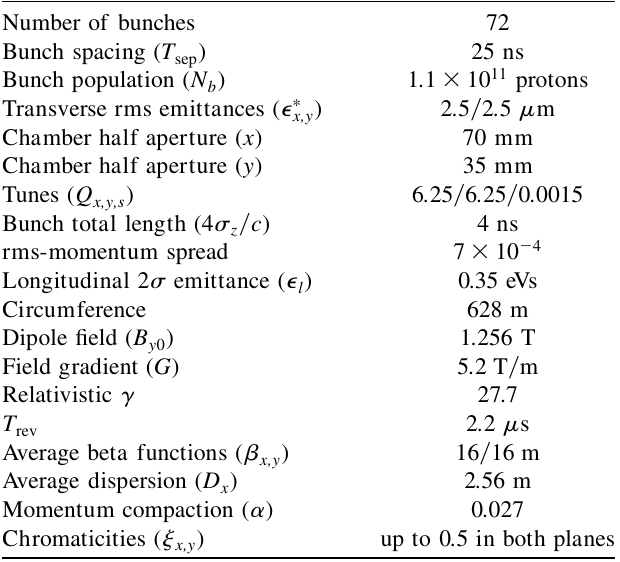
TABLE I. Main parameters of the LHC beam and PS